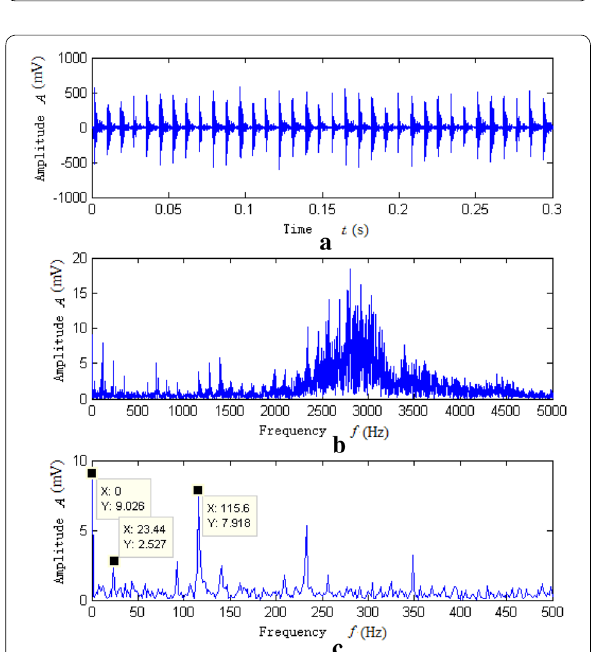
Figure 19 High frequency component of N205 with severe defect on the outer race: ( a ) time waveform, ( b ) FFT spectrum, ( c ) local